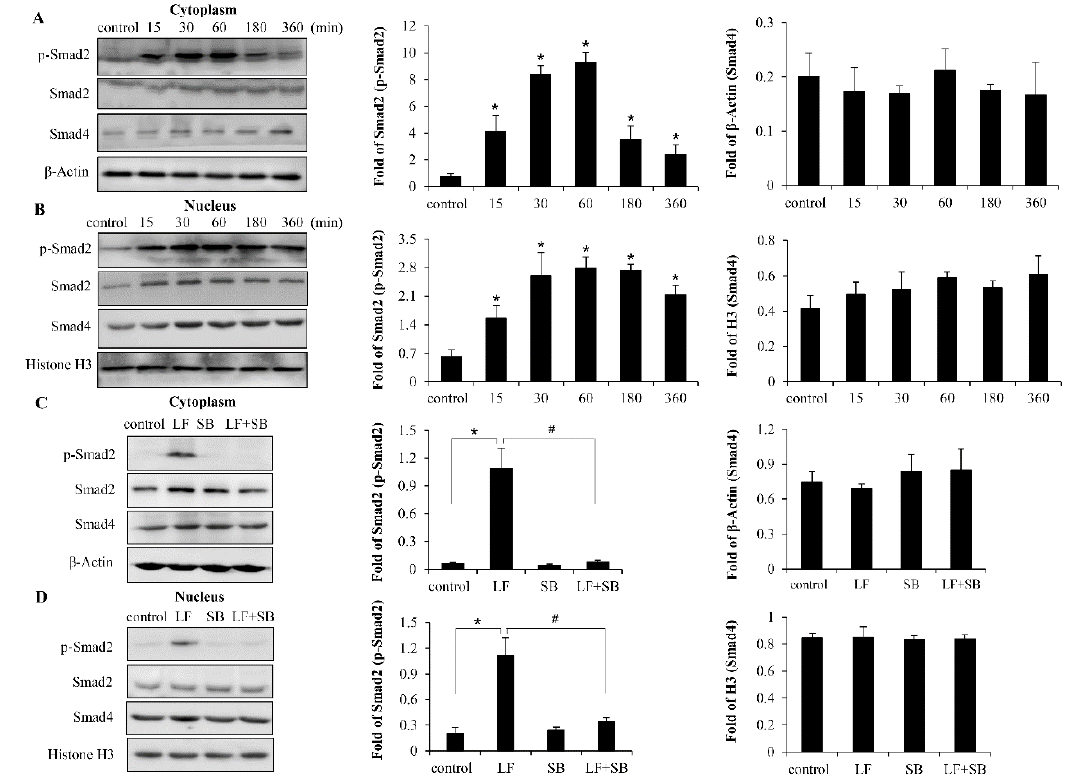
Figure 5. Western blot and the gray analysis showing activation of TGF- β / Smad2 signaling pathway by LF treatment in C3H10T1 / 2 cells. ( A , B ) Time-course analysis of Smad2 phosphorylation and nuclear translocation after treatment with 100 µ g / mL LF. ( C , D ) Pre-treating cells with SB attenuates LF (100 µ g / mL)-induced Smad2 and Smad4 activation. Values are mean ± SDs, n = 3. (* p < 0.05 versus control group; # p < 0.05 versus LF + SB treated group).